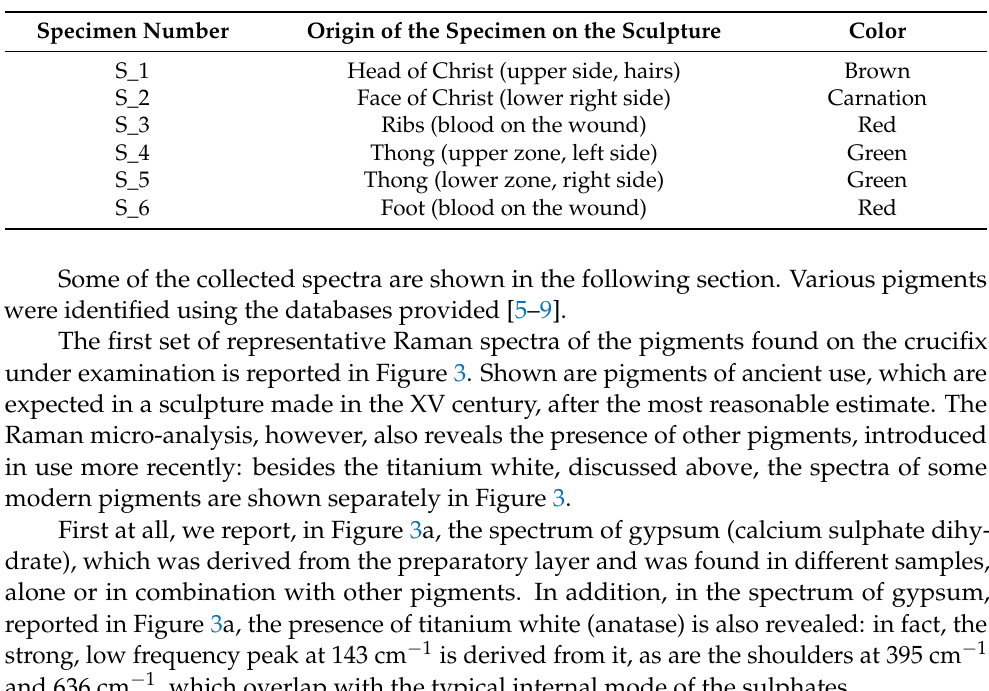
Figure 3. Representative Raman spectra collected on the specimen of Figure 2 with antique pigments: gypsum ( a ) hematite ( b ) vermillion ( c ) and carbon black ( d ). The Raman spectra shown in this picture were baseline-corrected. Table 1. Labels, and origin of the specimen on the sculpture and its dominant